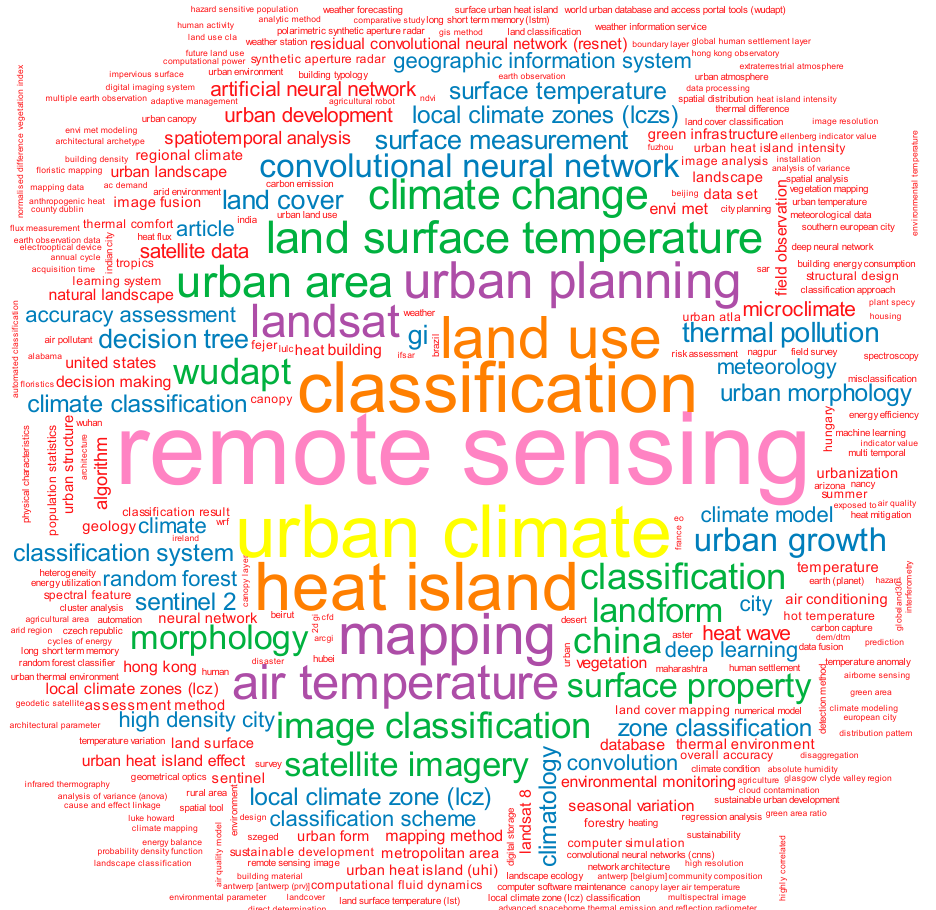
Figure 5. Tag cloud graph for LCZ classification topics.